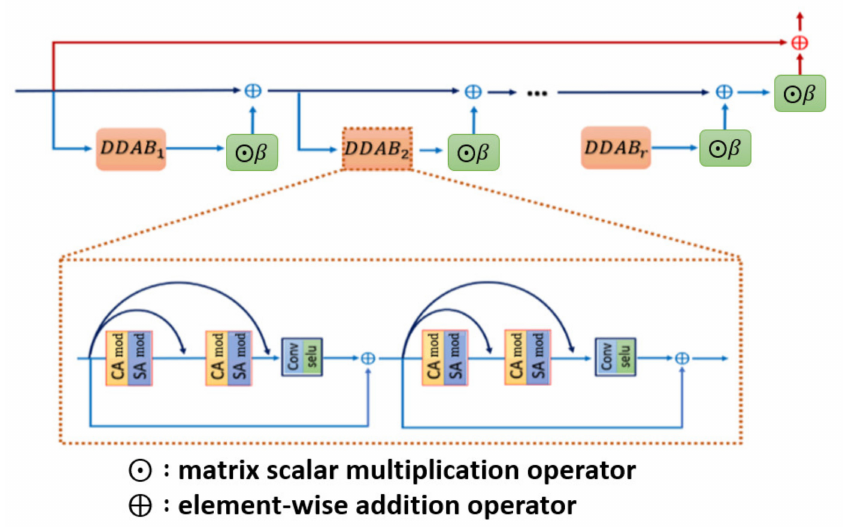
Figure 3. Dual-dimension attention block architecture. Each of the DDAB is composed of the proposed CAM followed by the SAM, which are able to figure out the ROI feature by investigating the cross-channel correlation as well as the inter-channel